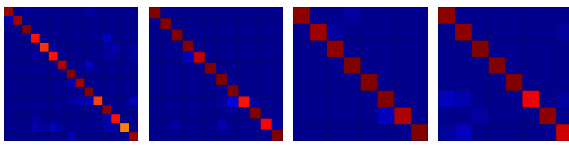
Figure 5: Confusion matrices (with blue and red colors corre- sponding to zero and one, respectively), κ -statistic, and balanced accuracy a for different datasets